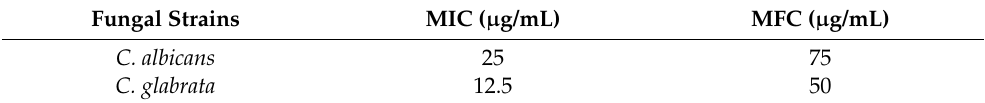
Table 2. MIC and MFC values of synthesized RsFb-AgNPs treated against selected fungal strains. Fungal